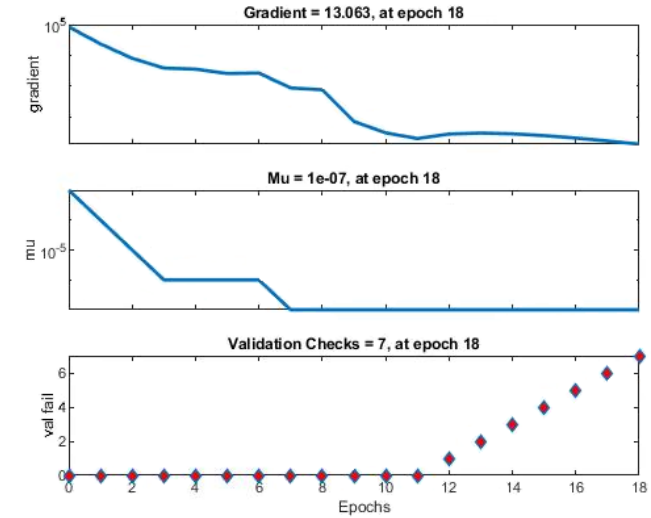
Figure 8. Neural Network Training state plots.